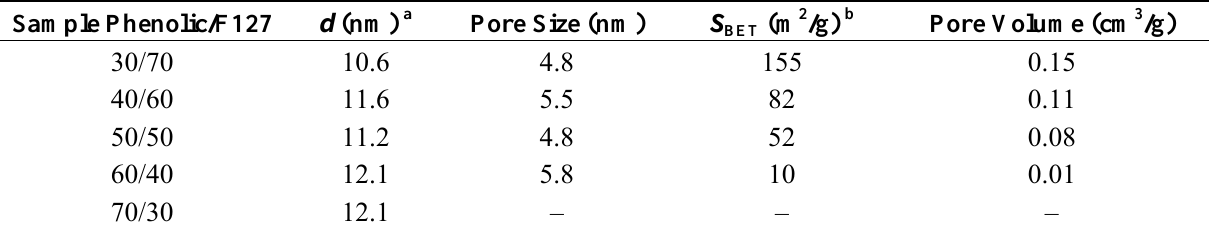
Table 1. Textural properties of mesoporous phenolic resins templated by F127. Sample